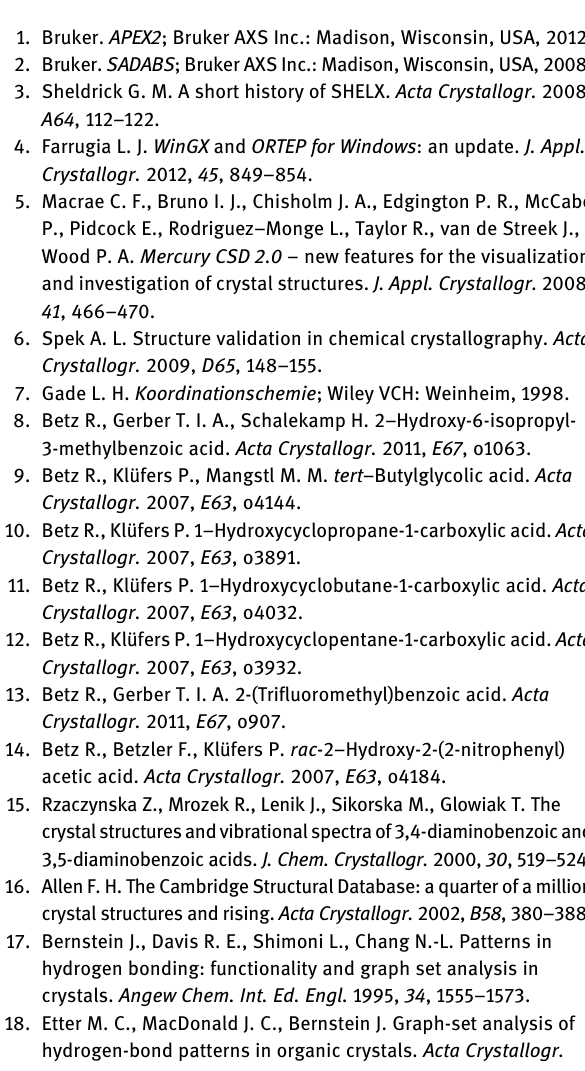
the CH group in meta position to the carboxylate substit- uent. In total, the molecules are connected to undulated double sheets along [1 0 1]. π -Stacking is observed with the shortest distance measured between two centers of gravity at just 3.6442(7) Å.